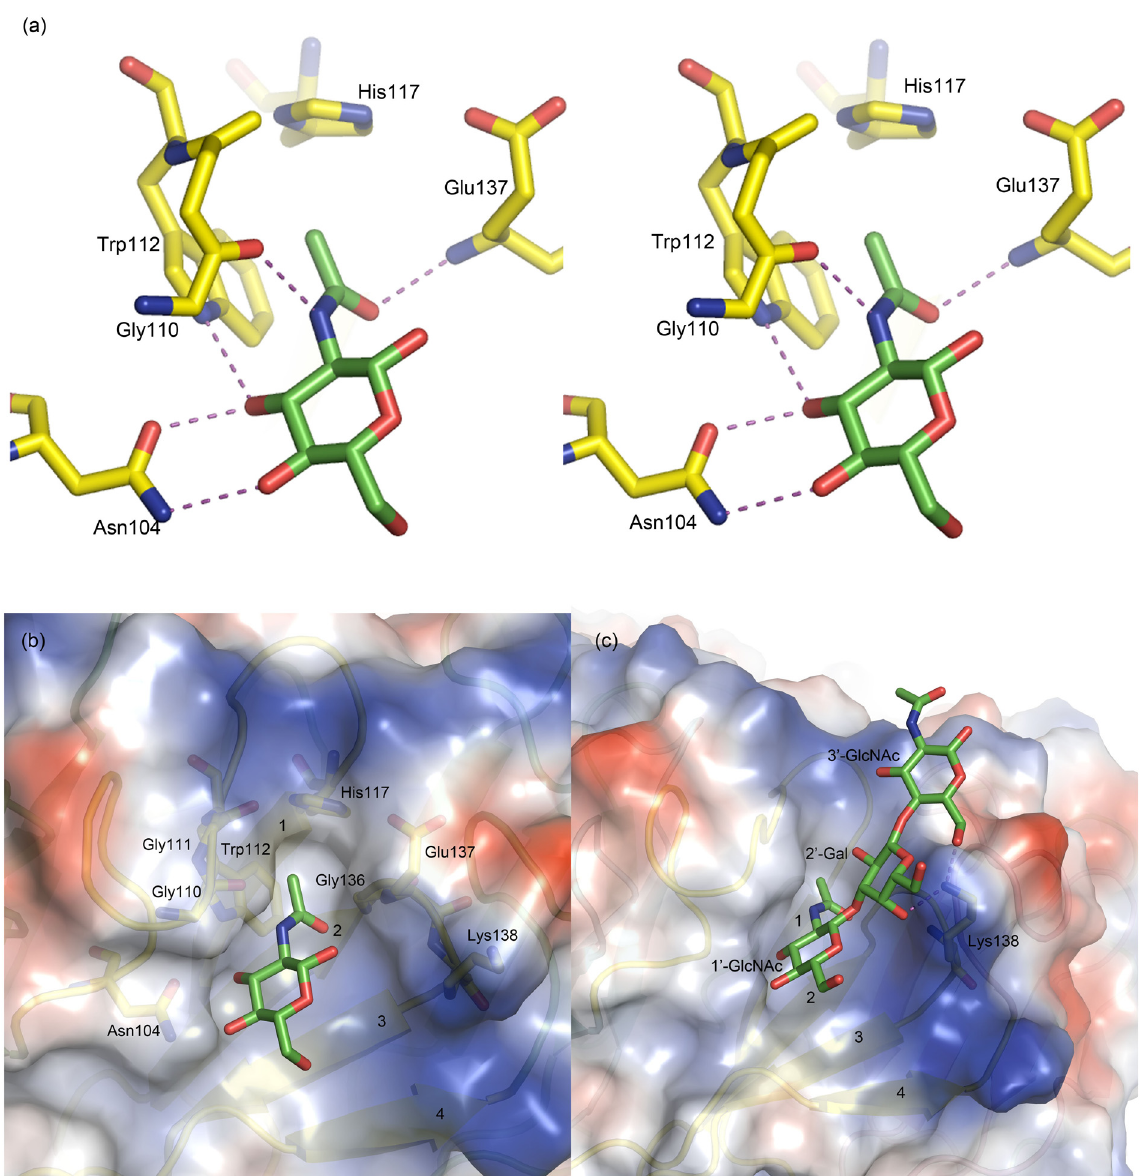
Fig 4. (a) Stereo view of GlcNAc bound to the binding pocket in WIII. (b) (c) Surface electrostatic potential diagrams of the binding pockets in WIII for GlcNAc and GlcNAc β 1-3Gal β 1-4GlcNAc,